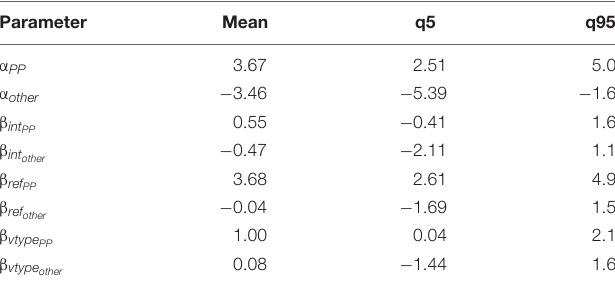
TABLE 14 | Mean estimate and credible interval for the parameters of the Mirror model, Experiment 2.